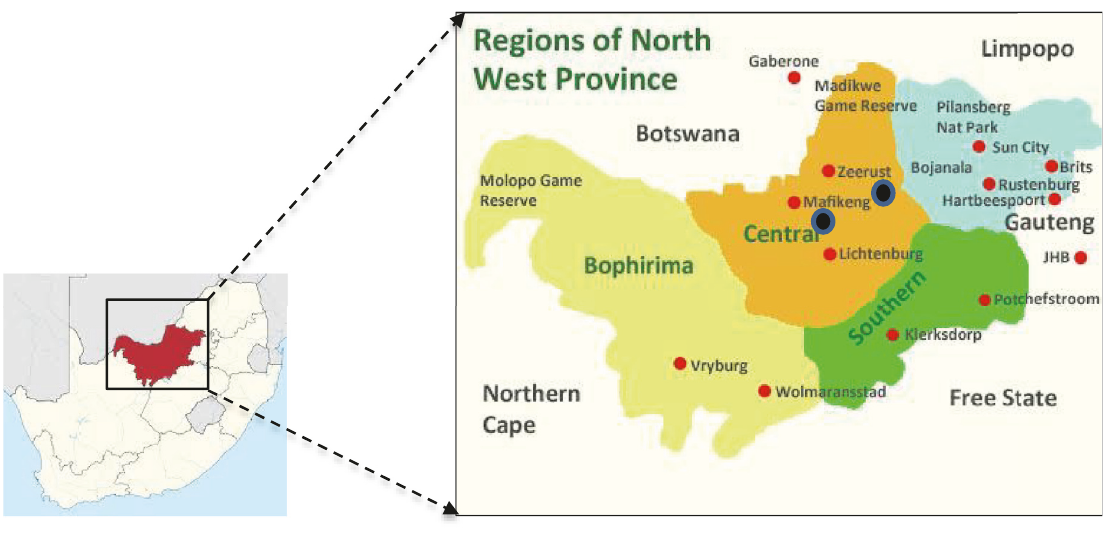
Figure 1: Map showing the North West Province and the sampling points depicted by the black